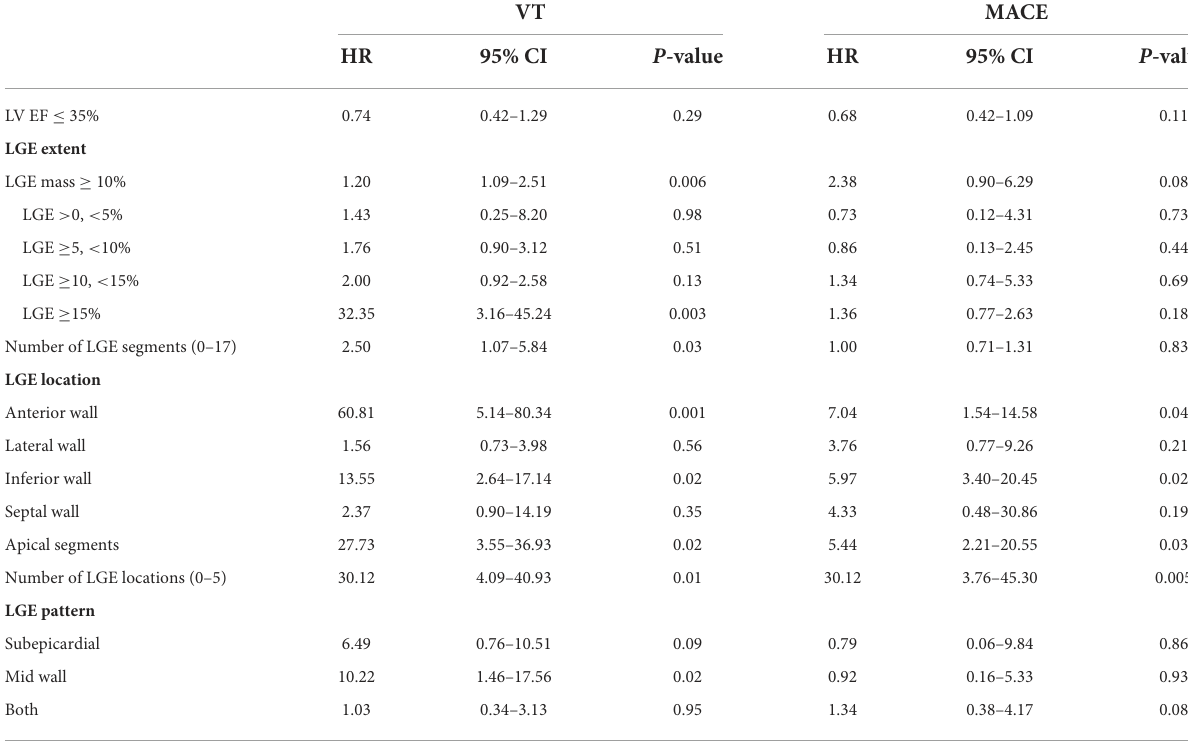
TABLE 6 Predictors for primary and secondary outcomes with patients with NICM on multivariate analysis adjusted for age, sex, and BMI. VT